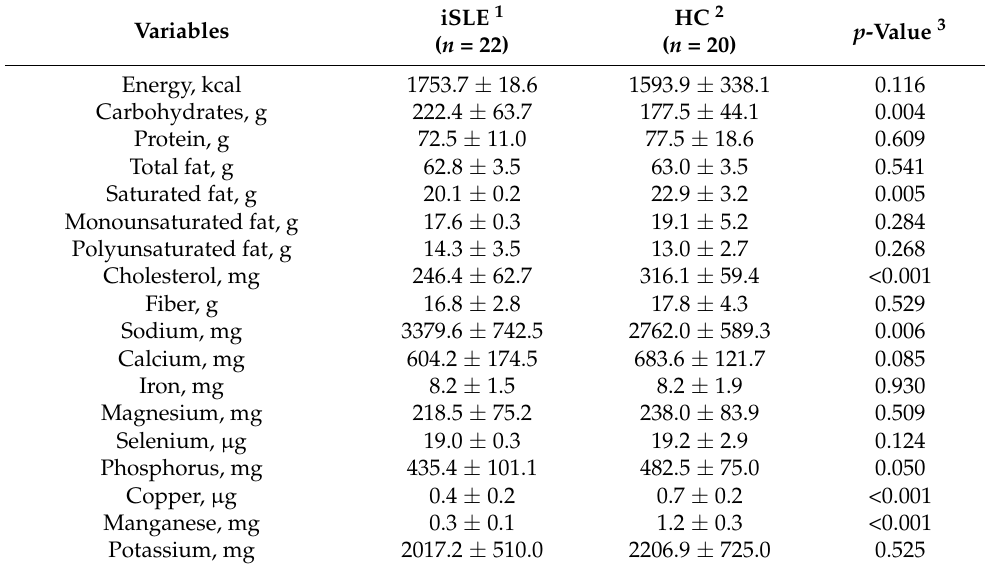
Table 2. Daily intake means of macronutrients and micronutrients of